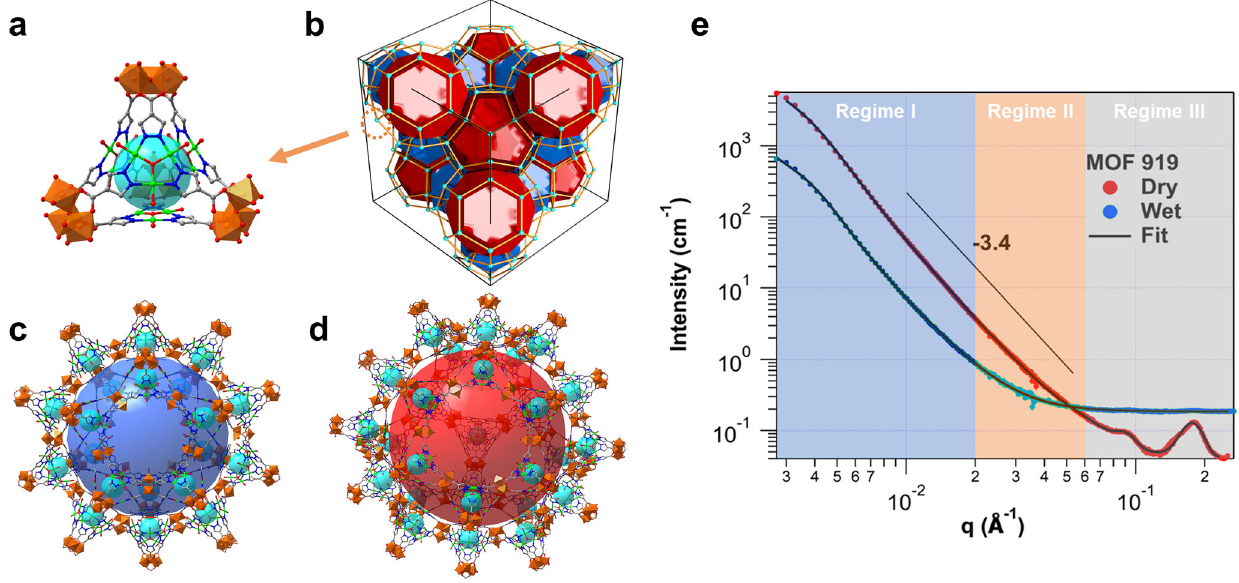
Fig. 1 | Structure and SANS pro fi les of MOF-919. a Microporous cage (cyan sphere). b Topology with unit cell (cyan: microcage, blue: small mesocage, red: large mesocage). c Small yys mesocage (large blue sphere). d Large liu mesocage (large red sphere). e SANS pro fi les of dry MOF-919 and MOF-919 in the contrast matching point of 50% D 2 O and 50% H 2 O mixture (wet). The solid lines